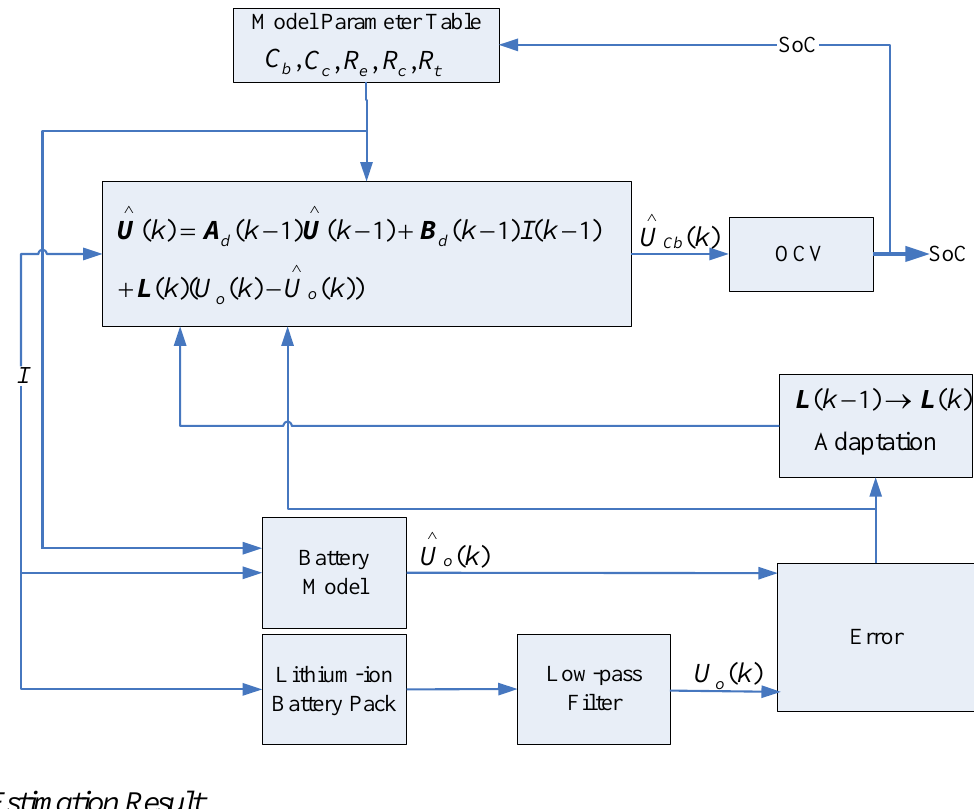
Figure 13. Adaptive observer based SoC estimation. Model Parameter